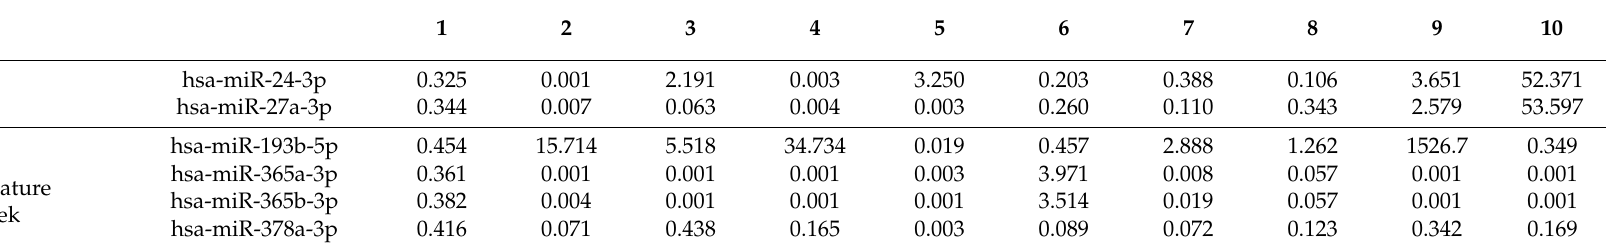
Table 2. Fold change of microRNAs with significant expression differences compared to the control group